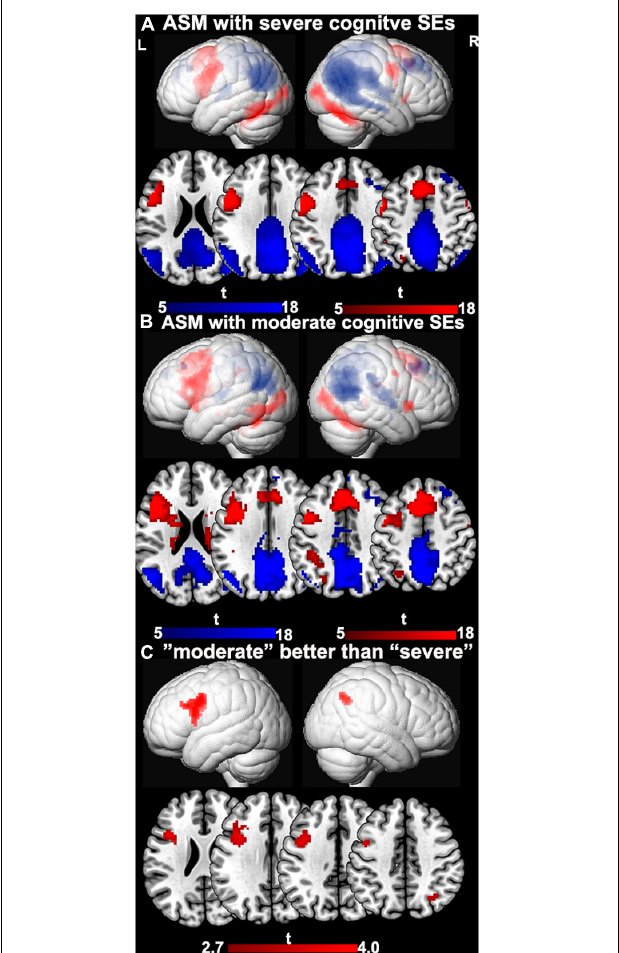
FIGURE 1 | The difference between ASMs with “moderate” and “severe” cognitive side-effects. (A) One-sample t- tests of functional magnetic resonance imaging activation and deactivation maps for the therapy groups with ASMs with “severe” cognitive side-effects are demonstrated on a surface-rendered brain template and subcortical changes are demonstrated superimposed on MNI 152 template with a bar chart indicating t score. Task-relevant activations (red) include bilateral inferior and middle frontal gyrus (left > right), bilateral supplementary motor area, the left dorsolateral parietal region, and bilateral inferior occipital lobes. (B) One-sample t- tests of functional magnetic resonance imaging activation and deactivation maps for the therapy groups with ASMs with “moderate” cognitive side-effects are demonstrated on a surface-rendered brain template and subcortical changes are demonstrated superimposed on MNI 152 template with a bar chart indicating t score. Task-relevant activations (red) include bilateral inferior and middle frontal gyrus (left > right), bilateral supplementary motor area, the left dorsolateral parietal region, and bilateral inferior occipital lobes. Areas of task-related deactivations (blue) include the bilateral precuneus, posterior cingulate, angular gyrus, and medial prefrontal and lateral temporal cortex. P < 0.05, FWE-corrected. (C) Significant group differences between ASMs with “moderate” and “severe” cognitive side-effects are demonstrated on a surface-rendered brain template and subcortical changes are demonstrated superimposed on MNI 152 template with a bar chart indicating t score. People on ASM with moderate SE profiles show greater activation in left frontal verbal fluency networks and greater deactivations in right inferior parietal lobe than people with severe SE profiles. P < 0.005, uncorrected, extent threshold 20 voxels. ASM, anti-seizure medication; L, left; R, right; SE, side